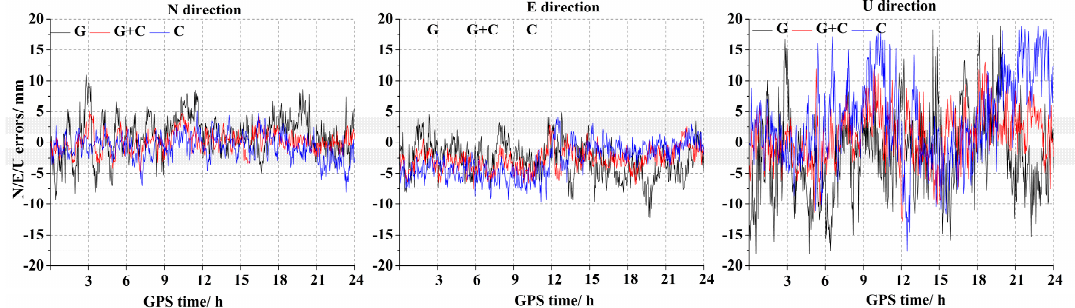
Figure 18. Deformation time series of QNT1.